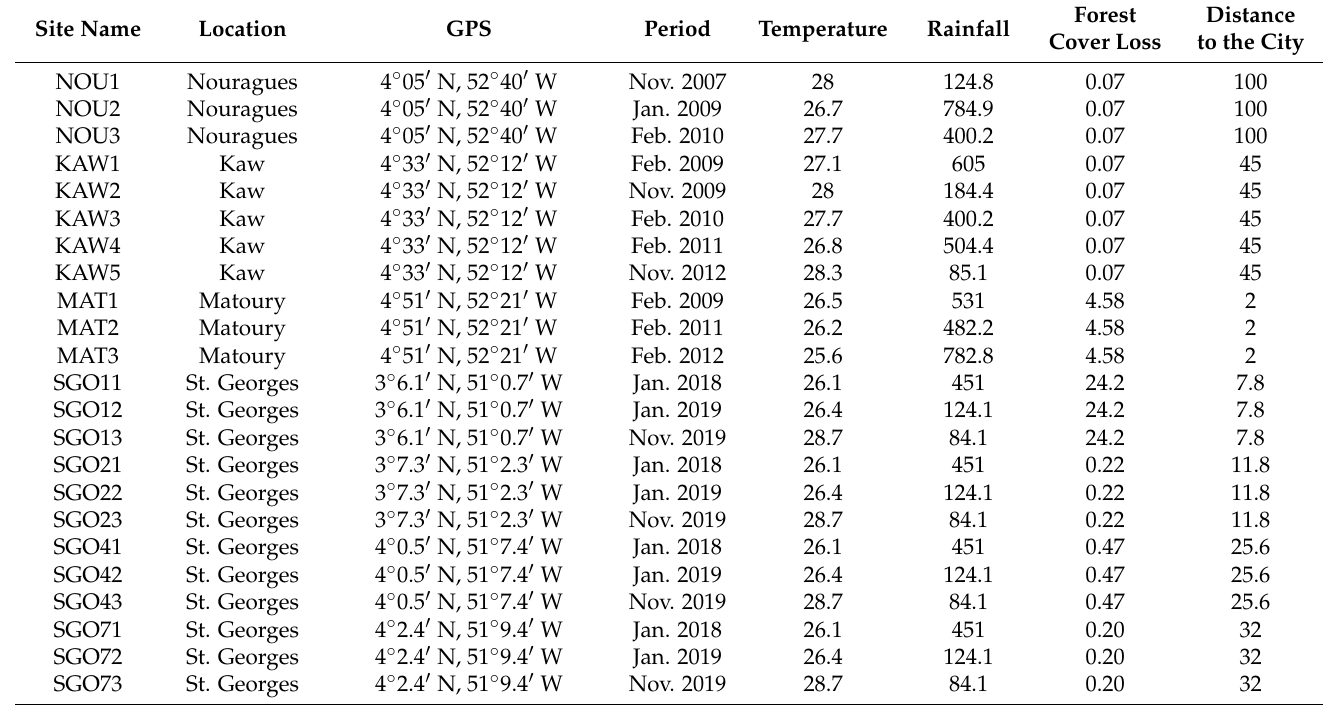
Table 1. Temperature ( ◦ C), monthly rainfall (mm), forest cover loss (%) and distance to the nearest city (km) by sampling period for all